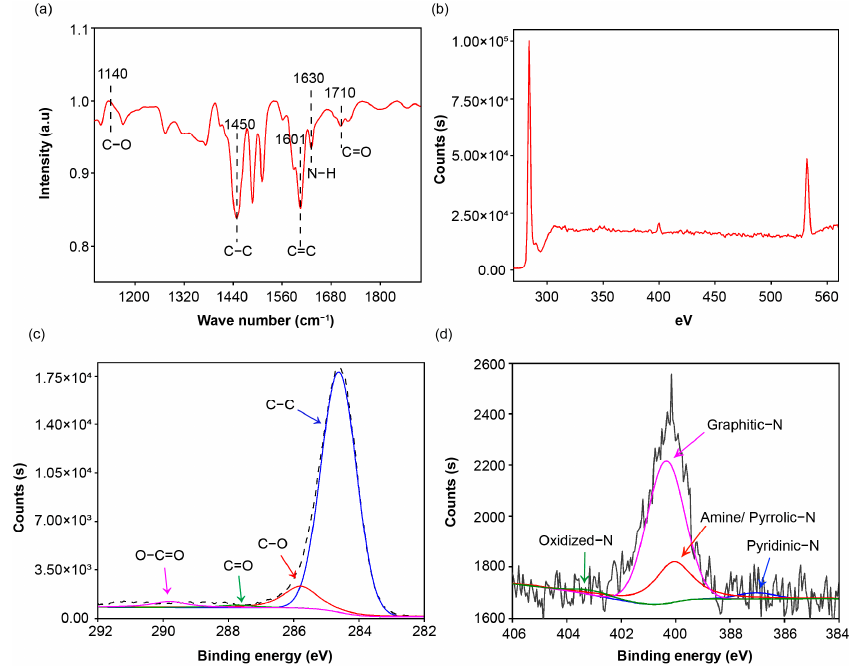
Figure 2. Functionalization of MPP. ( a ) FTIR spectrum of MPP; ( b ) XPS spectrum of MPP; ( c ) C1s XPS spectrum of MPP; and ( d ) N1s XPS spectrum of MPP. Table 1. Chemical contents and functional groups of C1s on MPP.